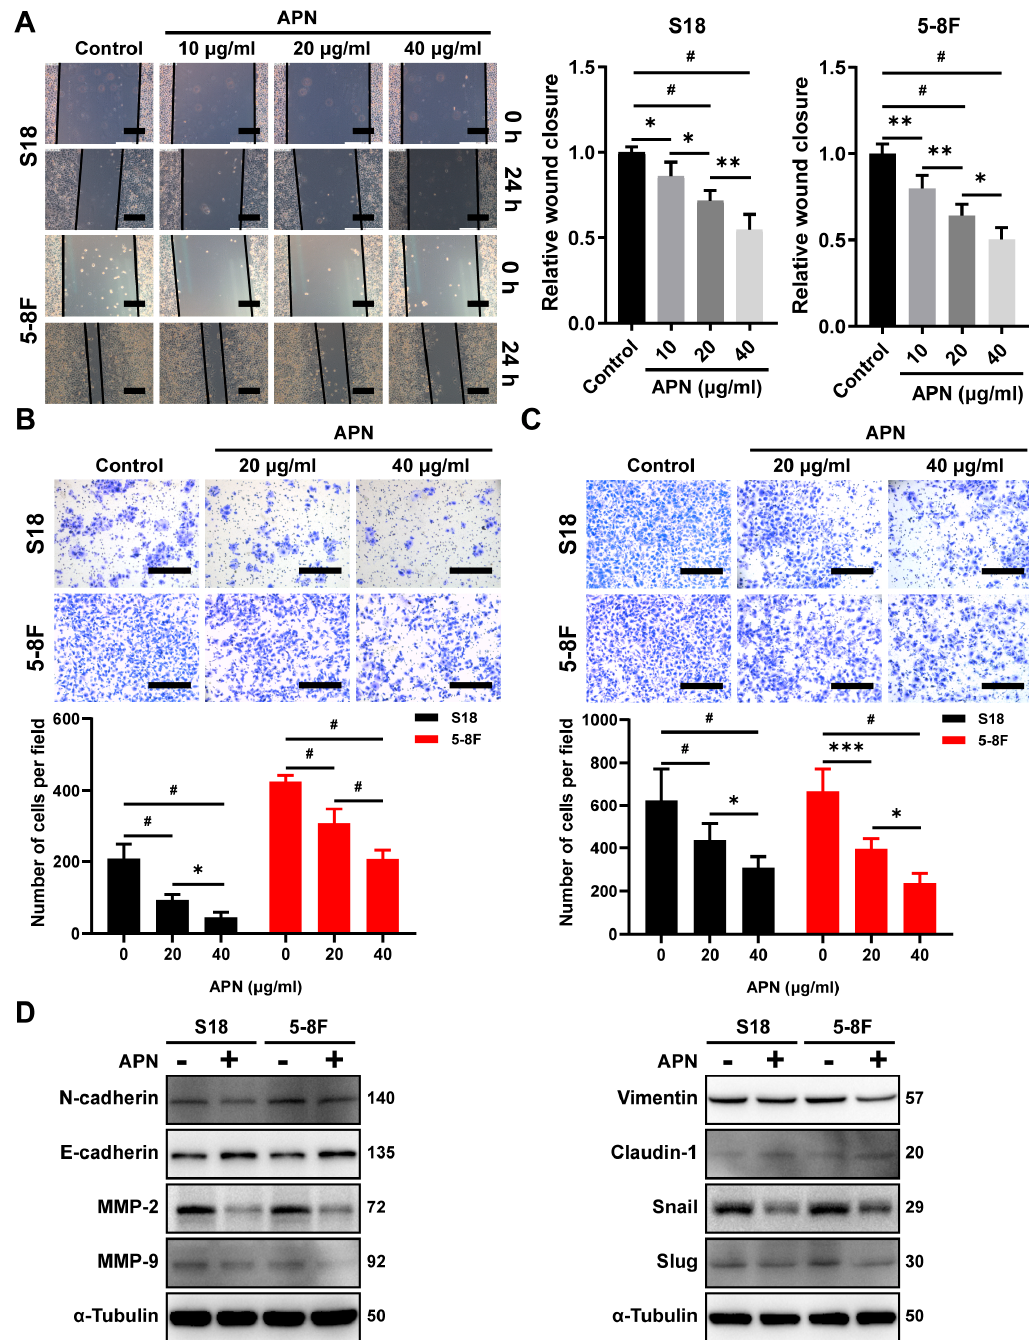
Figure 2. Adiponectin suppresses NPC cells invasion and migration. ( A ) Wound healing assay of S18 and 5-8F cells pretreated with adiponectin (0, 10, 20, or 40 μ g/mL) for 24 h. Scale bar: 200 μ m. Graphs show the relative wound closure. ( B ) Invasion of S18 and 5-8F cells were evaluated by Transwell invasion assay covered with Matrilgel after treatment with various dosing of adiponectin for 24 h. Scale bar: 200 μ m. Graphs show the relative number of invasion cells. ( C ) Migration of S18 and 5-8F cells were evaluated by Transwell migration assay after treatment with various doses of adiponectin for 24 h. Scale bar: 200 μ m. Graphs show the relative number of migration cells. ( D ) Western blot analysis of E-cadherin, N-cadherin, Slug, Snail, Vimentin, Claudin-1, MMP-2, and MMP-9 in S18 and 5-8F cells after treatment with 40 μ g/mL adiponectin for 48 h. Results are presented as mean ± SD of three independent experiments performed in triplicate. * p < 0.05, ** p < 0.01, *** p < 0.001, # p < 0.0001.